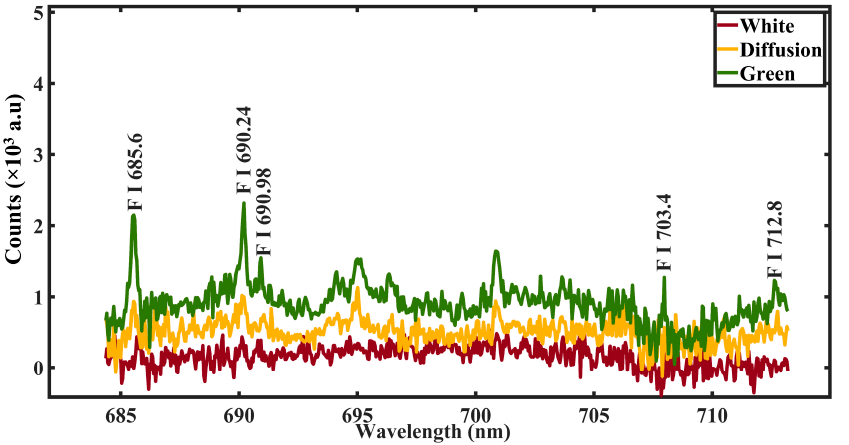
Figure 3. LIBS spectra of white, pale green (diffusion), and green zones of the sample in the wave- length range of 685–720 nm, showing the presence of fluorine in the green and diffusion zones. Table 2. Wavelength of persistence lines of atomic and ionic emission of elements found in the sample.